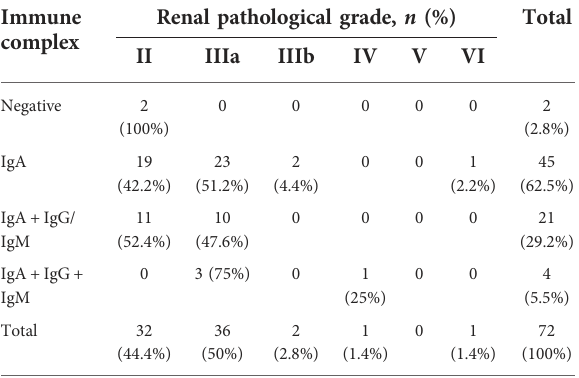
TABLE 6 Relationship between renal pathological grade and different types of immunoglobulin deposition. Immune complex